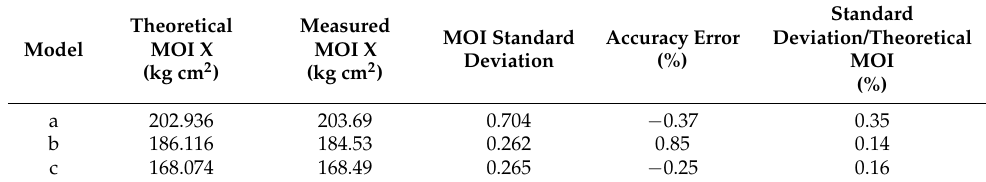
Table 3. Results summary of the references used to calibrate vertical MOI test stand.